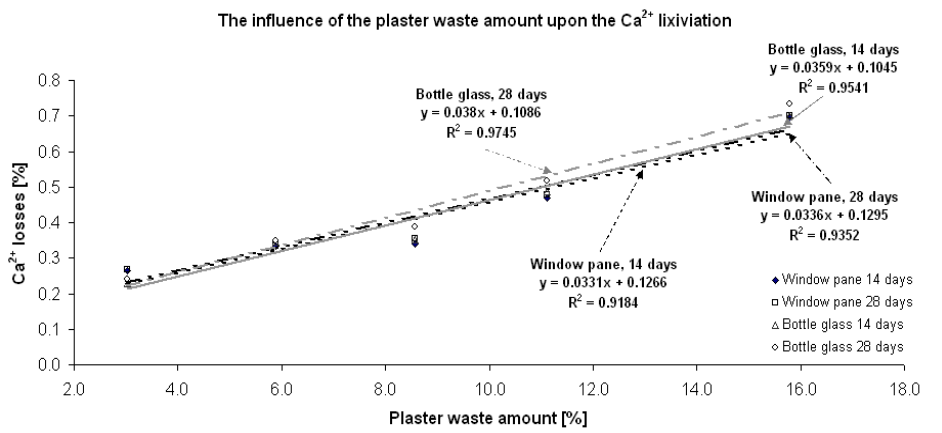
Figure 4. The influence of plaster waste amount upon the Ca 2+ ion lixiviated from the glass